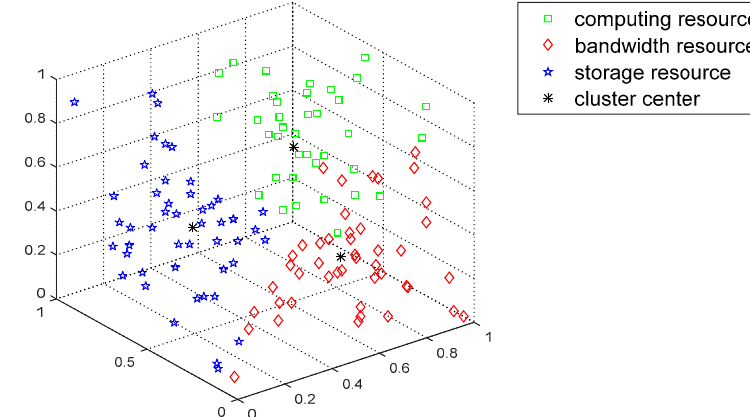
Figure 7. Original resources distribution.